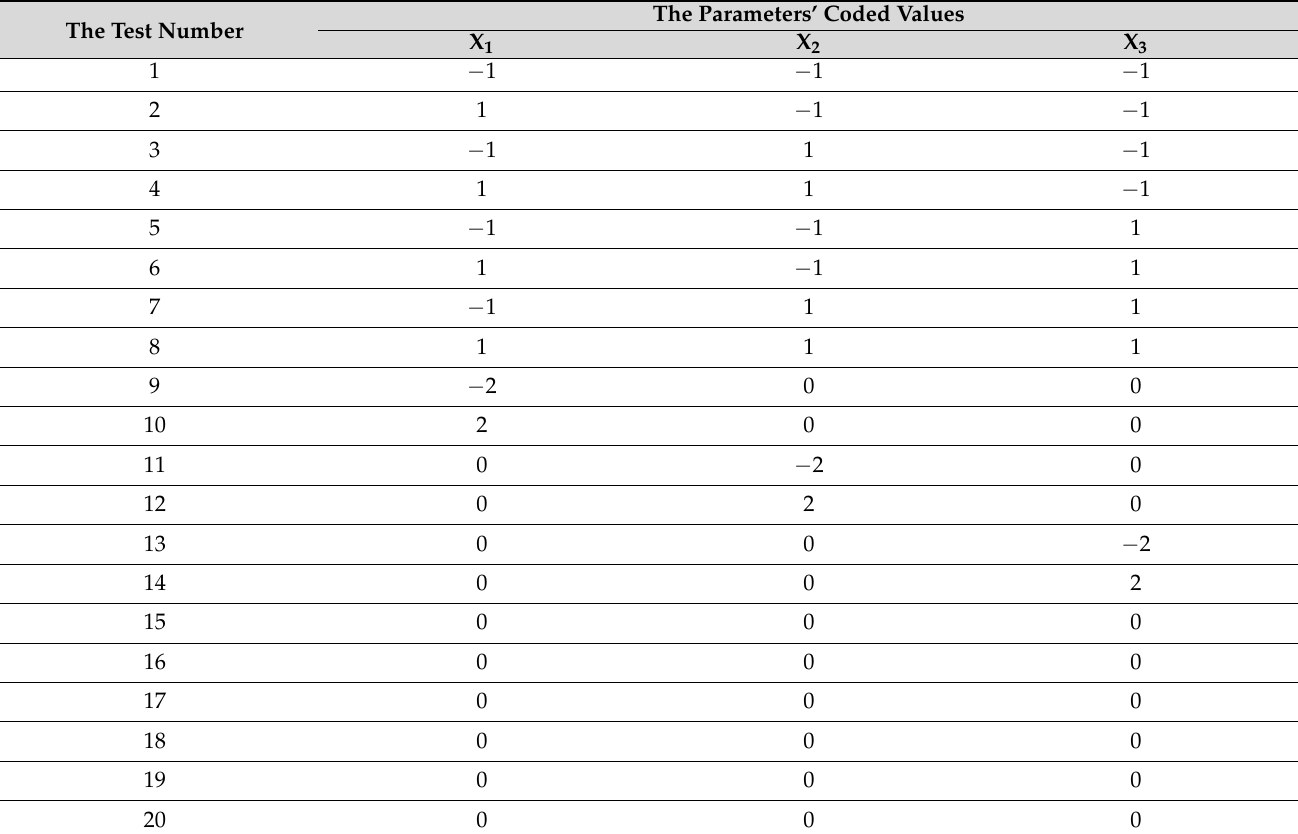
Table 2. The tests plan recommended by Minitab